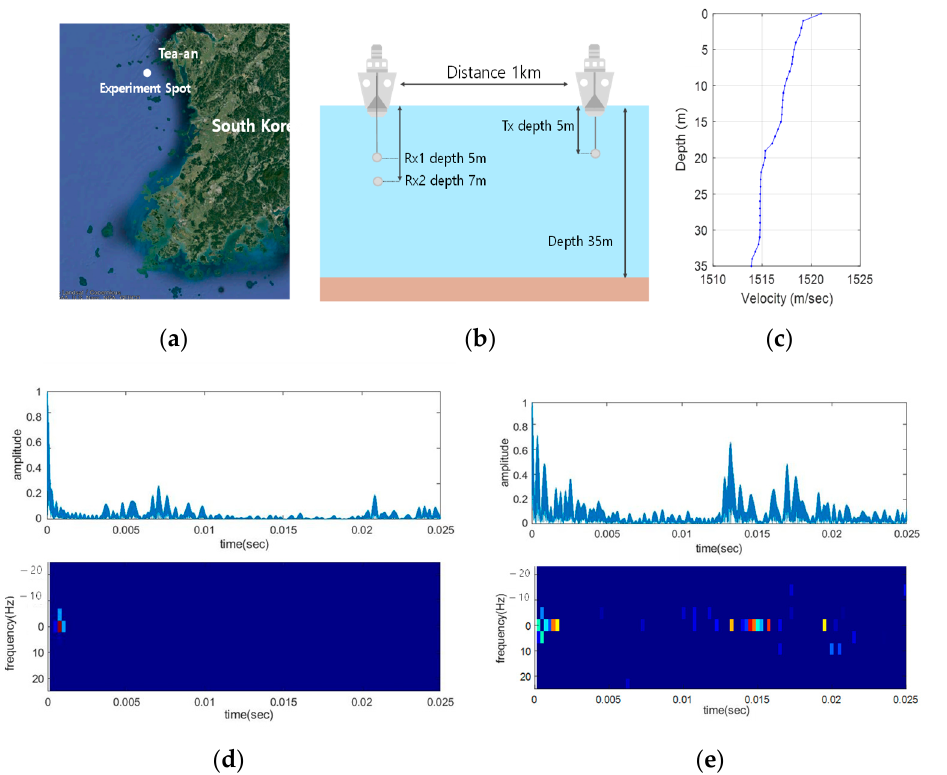
Figure 12. Ocean experiments environments:( a ) Location, ( b ) Configuration, ( c ) SVP, Delay profile and doppler spread: ( d ) 12:30 p.m., ( e ) 5:44 p.m.